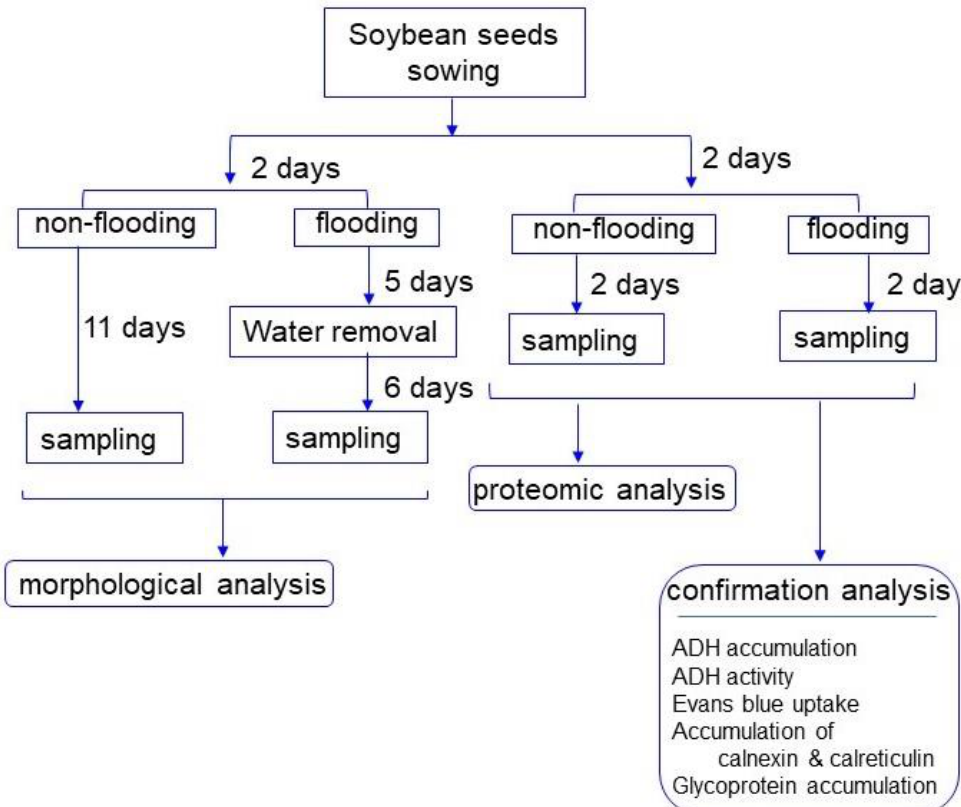
Figure 1. Experimental design for investigation of the mechanism of flooding tolerance in mutant soybean. As mutant lines, 1386-6 (G2), 1386-9 (G3), and 1387-12 (G4) lines were used. Soybean seedlings were analyzed with morphological and proteomics. Proteomic results were subsequently confirmed by immunoblot, enzyme activity, and physiological analyses. All experiments were performed with 3 independent biological replicates.